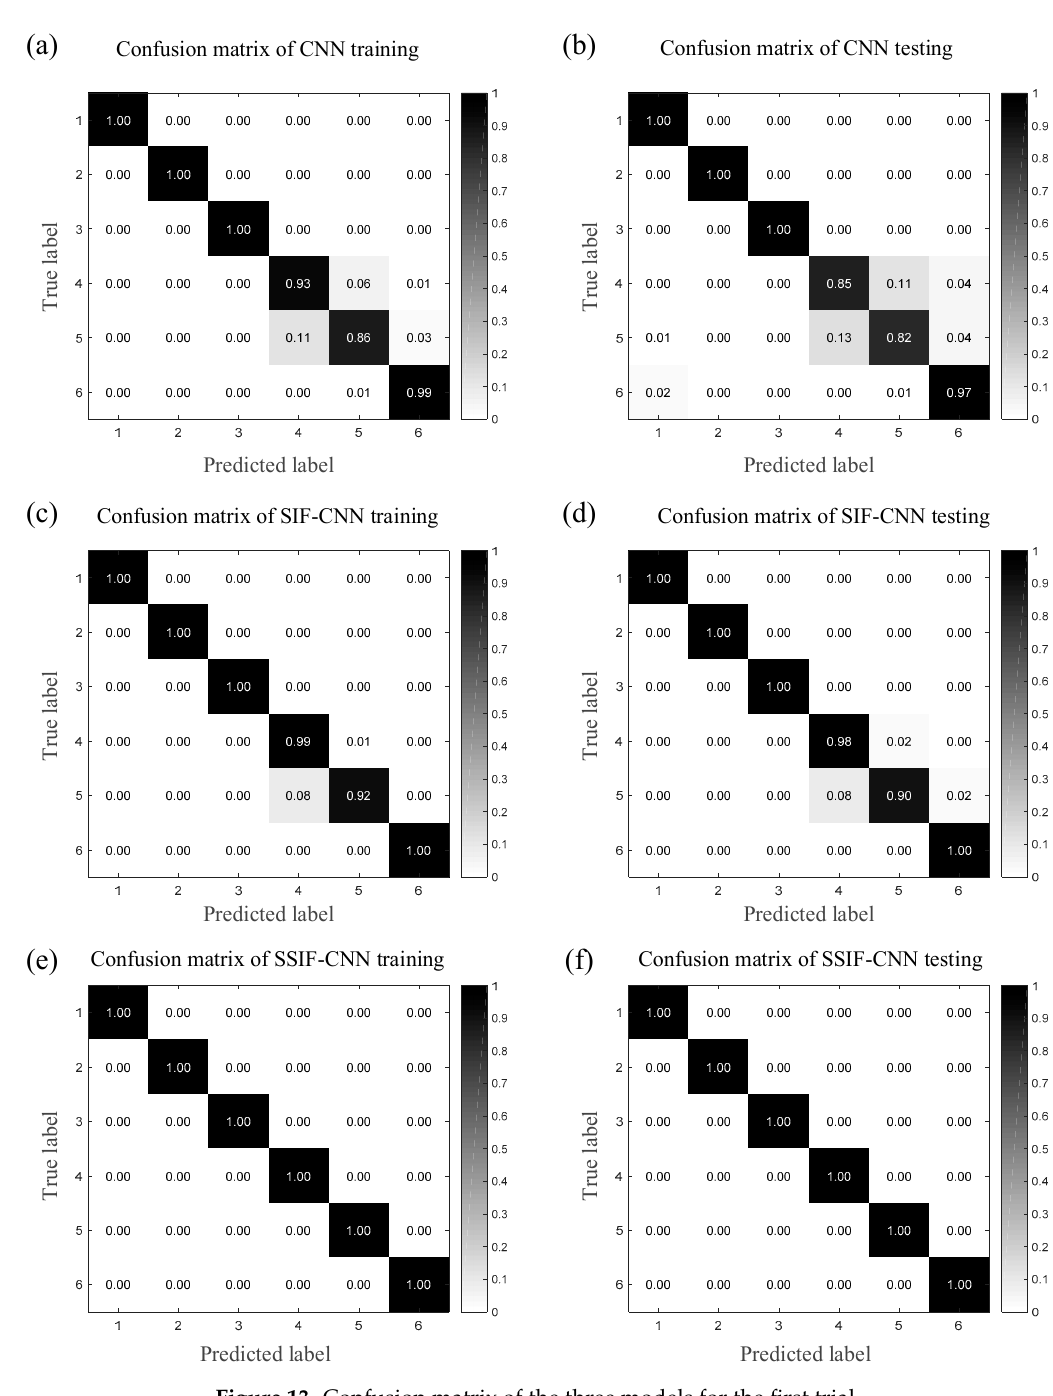
Figure 13. Confusion matrix of the three models for the first trial.